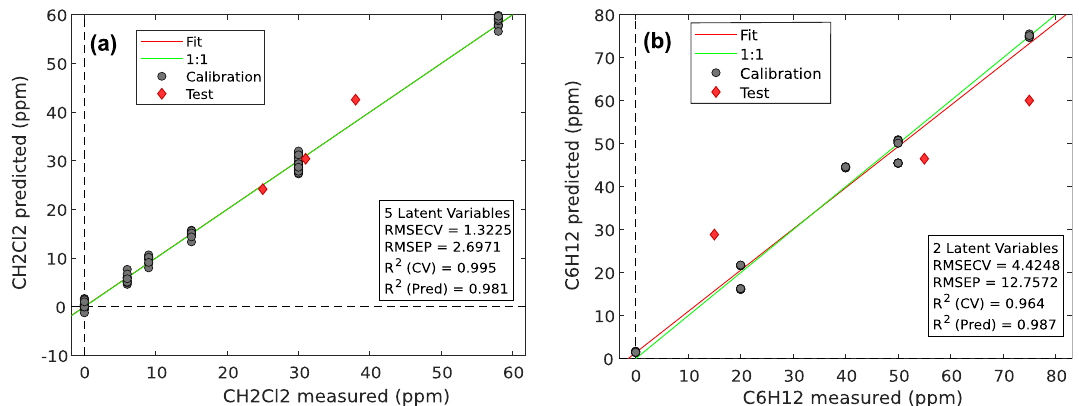
Figure 9. Prediction plots of the two models created with the spectra acquired on mixes of 4 components. ( a ) Prediction of CH 2 Cl 2 ( b ) Prediction of C 6 H 12 . In both plots, the black dots represent the spectra used to create and calibrate the model, and the red dots are the spectra used as the test set. The green line is the bisector of the plot, representing the ideal prediction, whereas the red line represents the linear fit of the